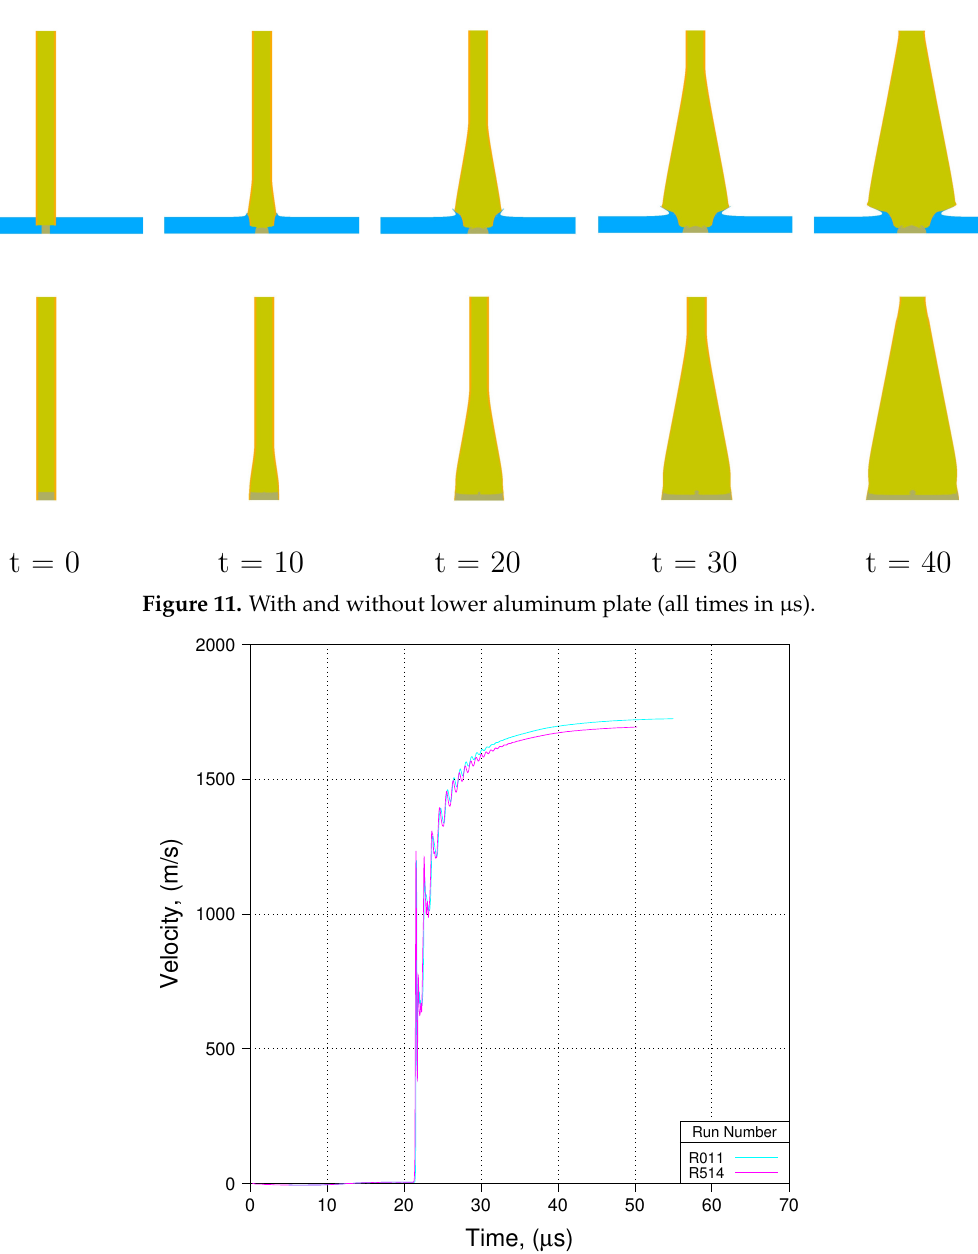
Figure 12. Impact of presence/absence of lower aluminum plate (Shot 01, Probe 08, Res 158.75 µ